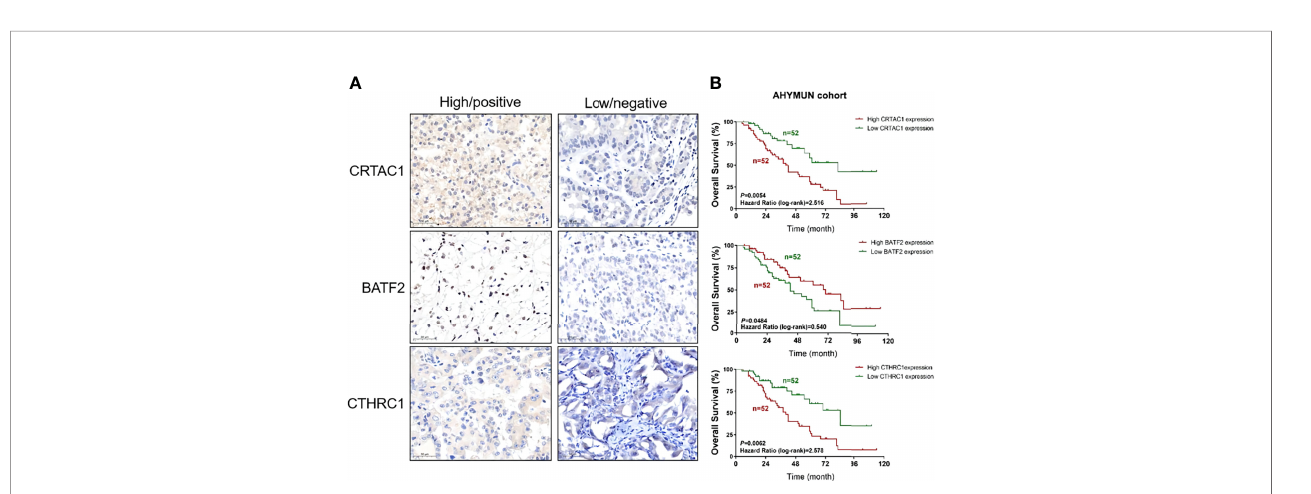
FIGURE 12 | Veri fi cation of this signature by other ones and external cohorts. (A – E) Test of the signature via GSE15459, GSE62254, GSE84437+GSE38749 +GSE34942, TCGA and GEO+TCGA. (F, G) Comparison among the signature with Zhang ’ s, Shao ’ s, Wang ’ s and Xiao ’ s ones.